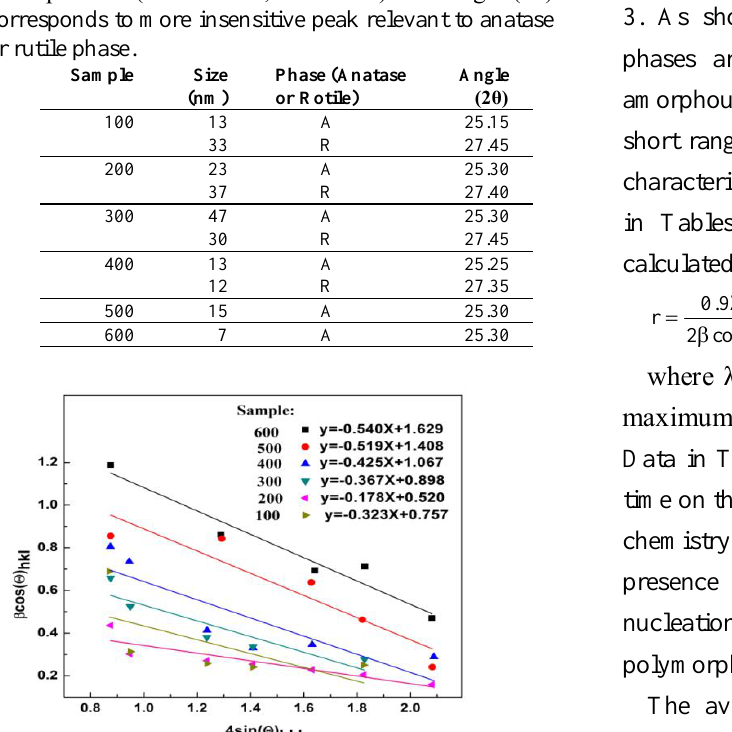
content and (b) the percent of rutile 2 content in table 2. 2